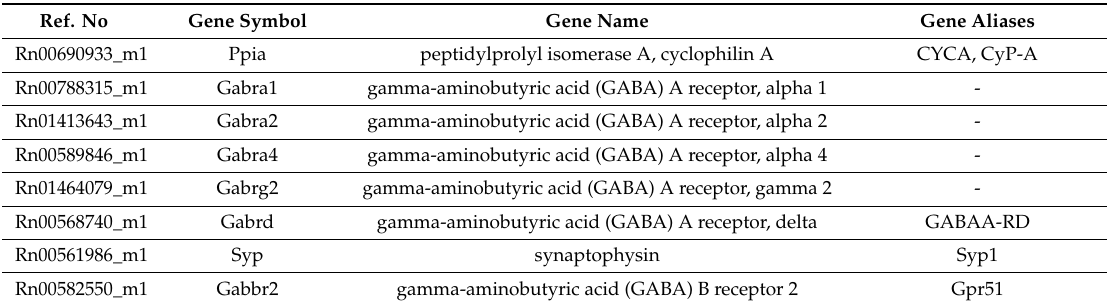
Table 1. List of TaqMan probes